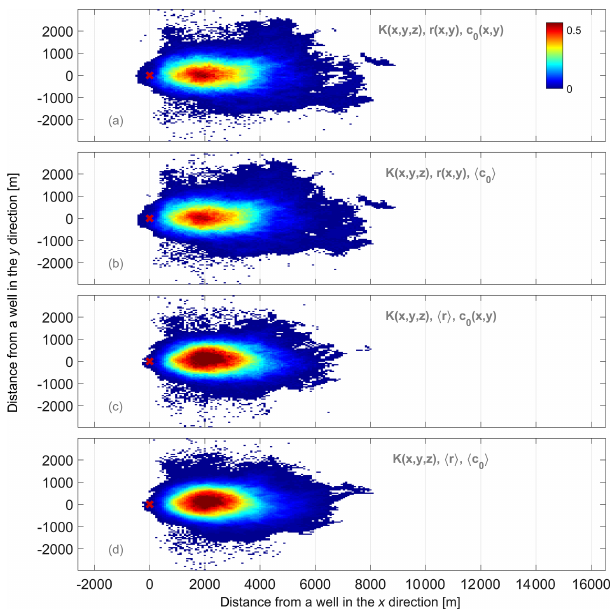
Figure 4. Probability of a particle leaving a given grid cell to reach a well accounting for a heterogeneous r and heterogeneous c 0 (ref- erence case, a ); a heterogeneous r and homogeneous c 0 (b) ; a ho- mogeneous r and heterogeneous c 0 (c) ; a homogeneous r and ho- mogeneous c 0 (d) ; a ln K -weighted r and ln K -weighted c 0 (e) .